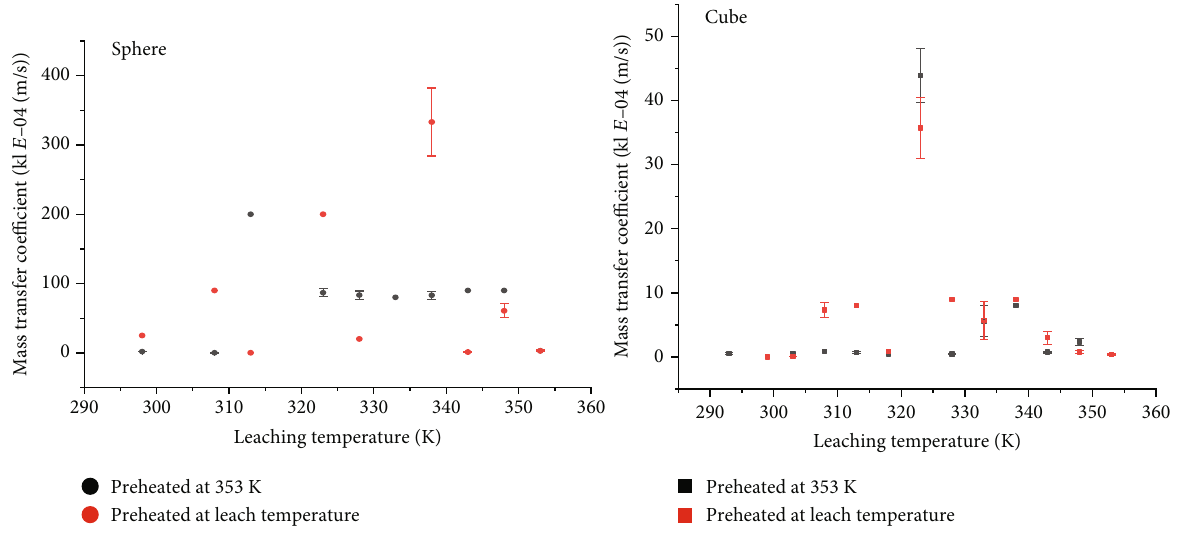
Figure 7: E ff ect of temperature on mass transfer coe ffi cient of potassium in preheated potatoes.